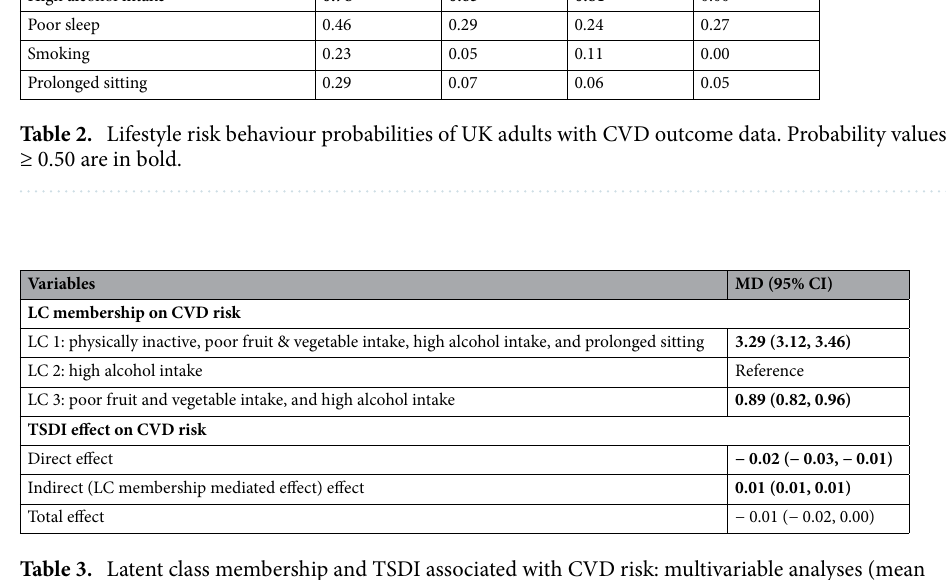
Table 3. Latent class membership and TSDI associated with CVD risk: multivariable analyses (mean difference and 95% confidence intervals). Significant values are in bold.